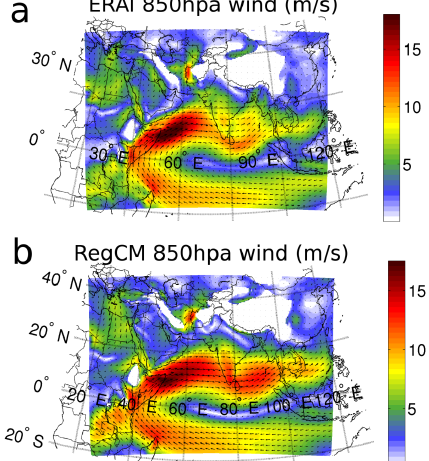
Figure 5. Mean 850hpa JJAS wind intensity and direction as seen in (a) the ERAI reanalysis and (b) the RegCM nodust simulation for the period 2000–2009 and over the CORDEX-India domain. All modeling results represent a three-ensemble-member